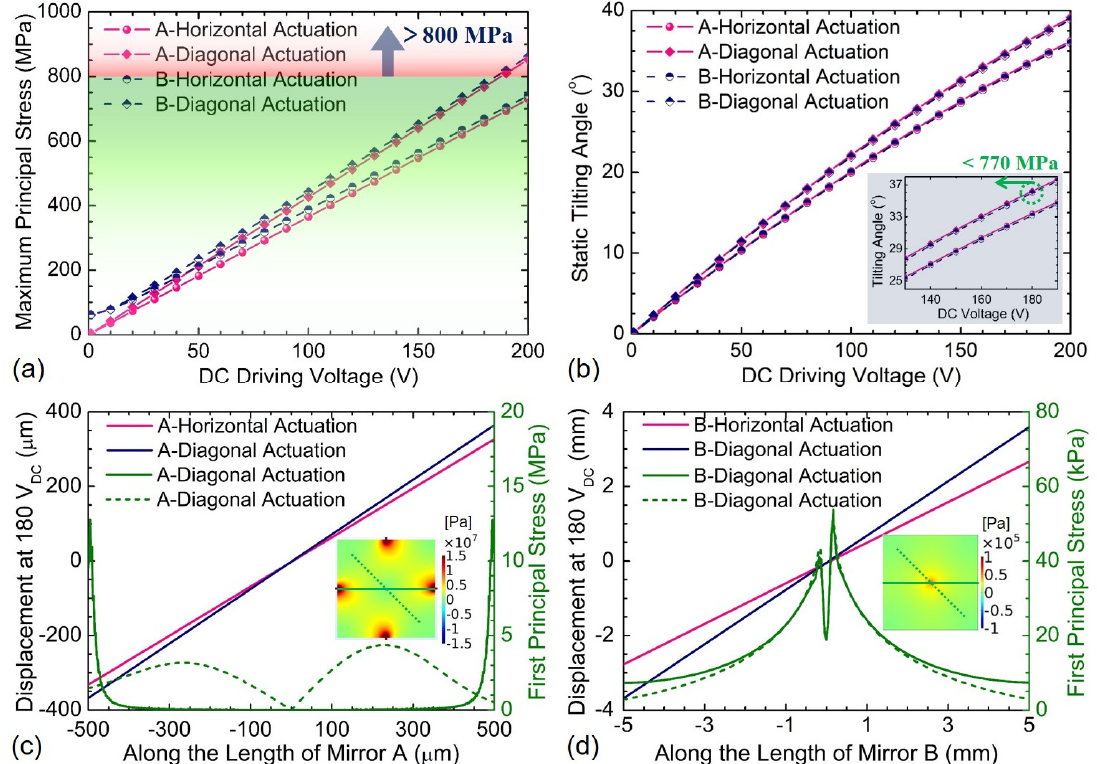
Figure 10. Comparison of dependence of the maximum principal stress and tilting angle on the DC driving voltages for Devices A and B with gravity: ( a ) maximum principal stress, ( b ) static tilting angle, ( c , d ) displacement. Table 4. Static performance comparison between the MEMS mirrors presented here and in the literature.